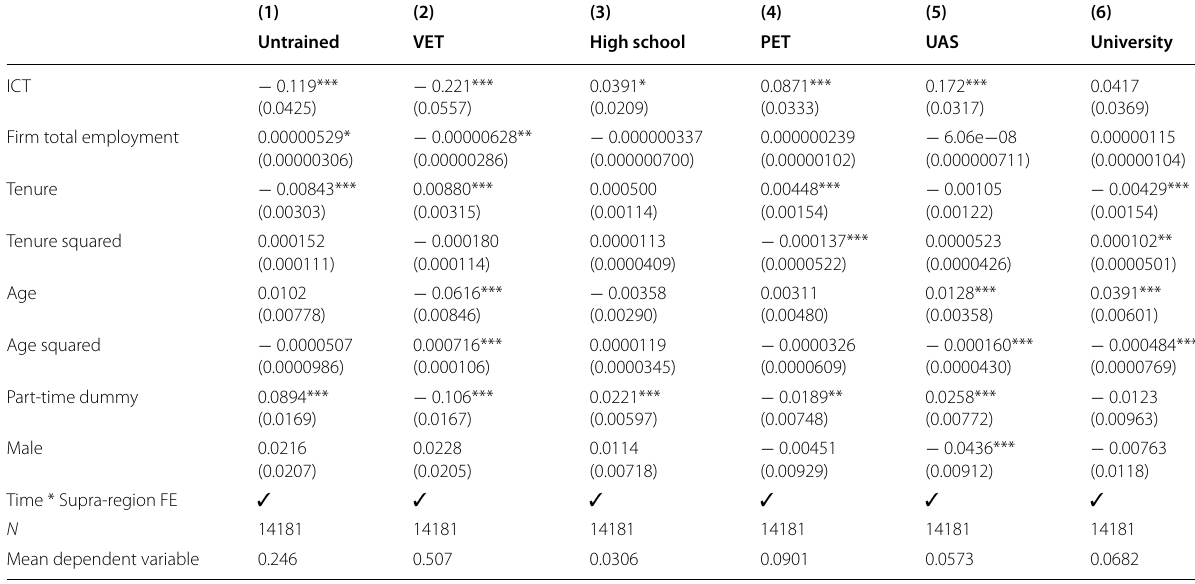
Table 16 Pseudo-panel FE estimation. Cells based on 16 supra-regional labor market instead of 106 local labor market regions